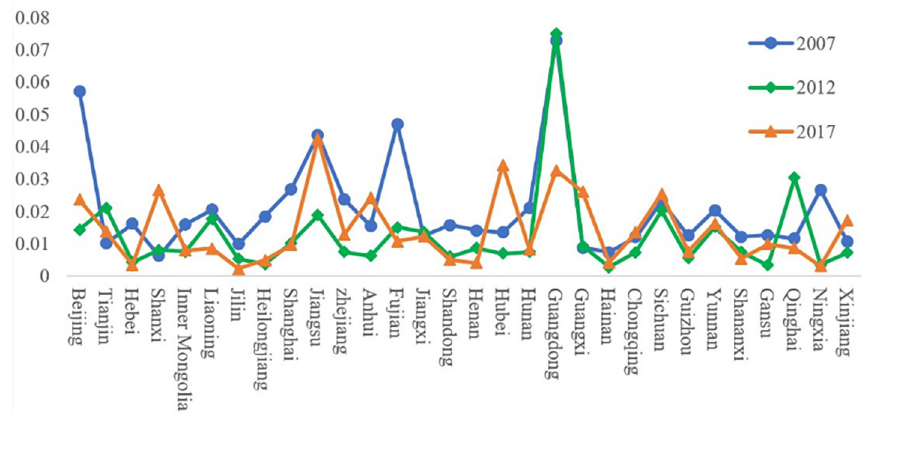
Fig 4. Integration level of the digital economy core industry and logistics industry in 30 provinces and municipalities in China in 2007, 2012 and 2017.